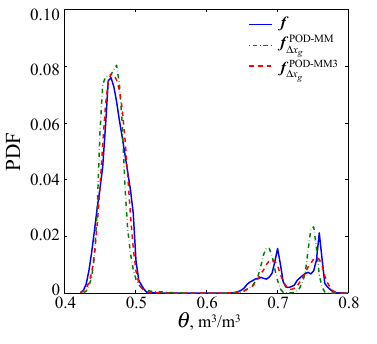
Figure 14. The mean POD error ¯ e POD at site A based on a site- independent ROM constructed using a POD method that only uti- lizes soil moisture solutions from sites B, C, and D.